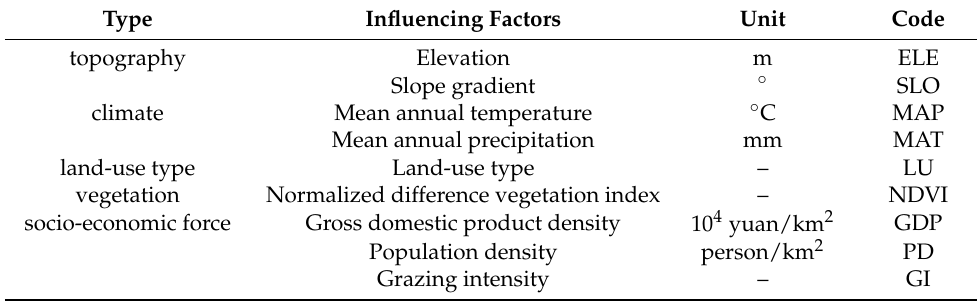
Table 3. Selection of potential influencing factors of ESs in the Tianshan Mountains.